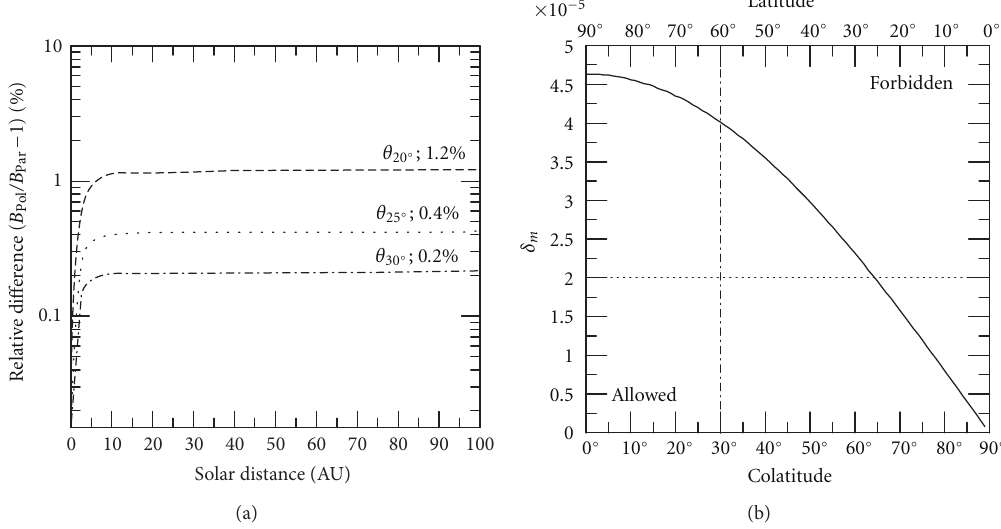
F 1: (a) Maximum percentage difference between the �allowed� region guarantee that the stream line originated from the polar magnetic �eld do not cross the equatorial plane. Since (5) is symmetric with respect to the solar equatorial plane, values greater than